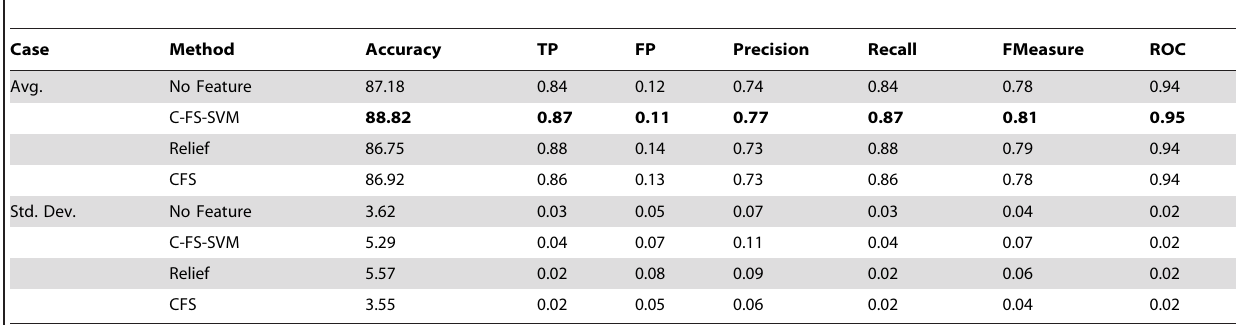
Table 3. Standard Deviations of classification results for external cross validation with MLP and their average performance results for each metric.